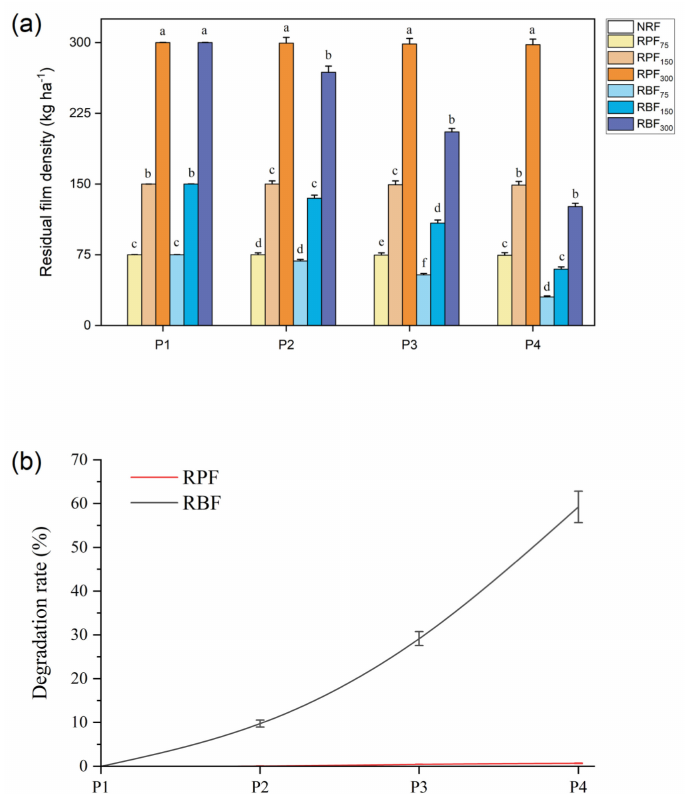
Figure 3. Dynamic changes of residual film density under different treatments ( a ), and degradation rate of different types residues ( b ) during the two-year experiment (P1: before sowing in 2020, P2: after the harvest in 2020, P3: before sowing in 2021, and P4: after the harvest in 2021). Vertical bars represent the standard error of the mean. Different lowercase letters indicate significant ( p < 0.05) differences based on the LSD test. (NRF, no residual film; RPF 75 , 75 kg ha − 1 of residual plastic film (RPF); RPF 150 , 150 kg ha − 1 of RPF; RPF 300 , 300 kg ha − 1 of RPF; RBF 75 , 75 kg ha − 1 of residual